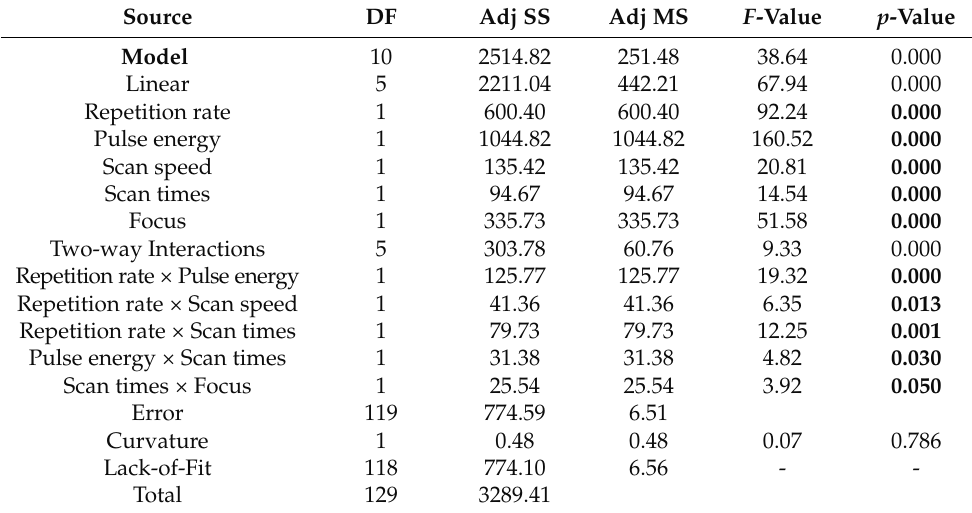
Table 4. ANOVA table for pocket Depth